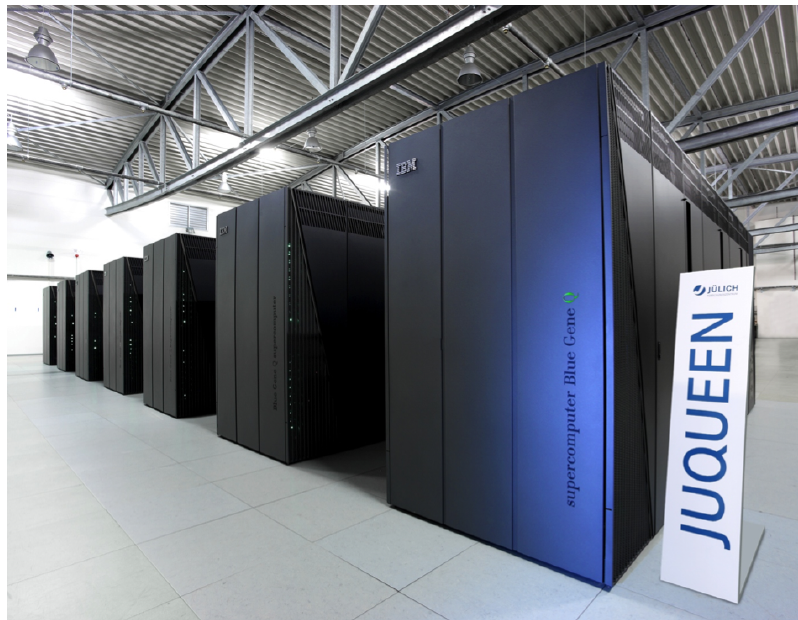
Figure 1: JUQUEEN at the Jülich Supercomputing